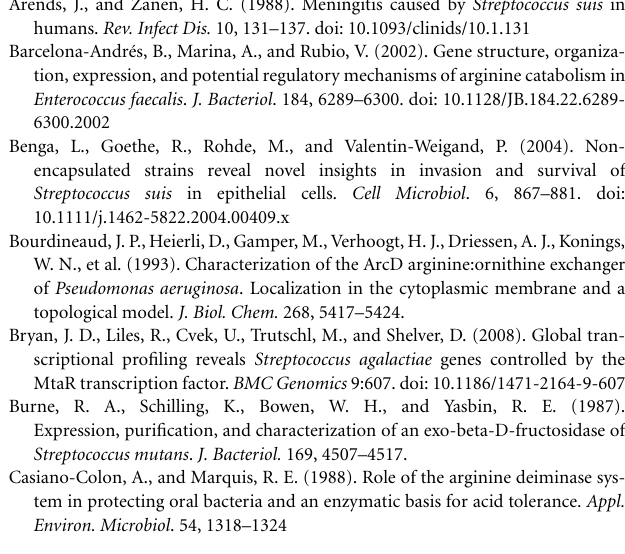
FIGURE 4 | ArcD facilitates survival under acidic conditions. (A) S. suis strain 10 (black bars) and 10 (cid:2) arc D (white bars) were incubated for 4h in a phosphate buffer supplemented with arginine and adjusted to the depicted pH values. Acidic resistance was monitored by replica-plating. Results are given as percentage of the inoculum. Phosphate buffer adjusted to pH 5 without arginine supplementation served as negative control. Data represent means and standard deviations of a representative experiment performed in triplicates. Experiments were repeated at least four times. (B) Intracellular survival of the wild-type strain 10 and strain 10 (cid:2) arc D in HEp-2 cells that were treated with bafilomycin (200nM) for 1h before infection (black bars) and in untreated cells (white bars). Results are given as percentage of intracellular bacterial survival after 2h. Data represent means and standard deviation of three independent experiments. Results were considered statistically significant with p < 0 . 05 in a one-tailed t -test, as indicated by asterisks.